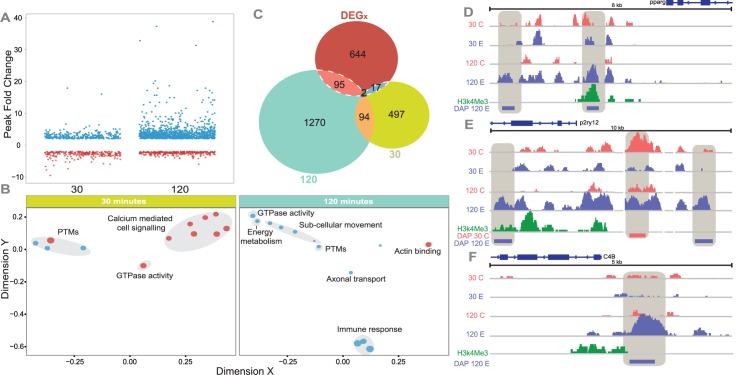
Connecting gene expression and chromatin accessibility in diencephalon.(A) Fold change of differentially accessible peaks at 30 minutes and 120 minutes; blue indicates up in experimental, red indicates down in experimental. (B) Functional enrichment (molecular function) of genes associated with differentially accessible peaks at 30 minutes and 120 minutes. Blue indicates up in challenged, red indicates down in challenged. (C) Overlap of genes whose expression profile changed over time in response to a social interaction (DEGx) with genes associated with differentially accessible peaks at 30 minutes and 120 minutes. The overlap between DEGx and accessibility at 120 minutes is statistically significant (P<0.0001). (D-F) Examples of differentially accessible peaks around DEGx. Separate tracks are shown for H3K27Ac peaks in control 30 min, experimental 30 min, control 120 min, experimental 120 min, and H3k4Me3, which marks the location of the promoter. (D) Pparg (a TF in D9 and also present TRN) was more accessible at 120 minutes and was also up-regulated at 120 minutes. (E) P2ry12 (cluster D9) is purinergic receptor involved in synaptic plasticity [65] that was more accessible in controls at 30 minutes then become more accessible in experimental animals at 120 minutes. P2ry12 is known to stimulate microglia migration toward neuronal damage [66]. (F) C4B (cluster D9) was not accessible at baseline but became accessible at 120 mins.